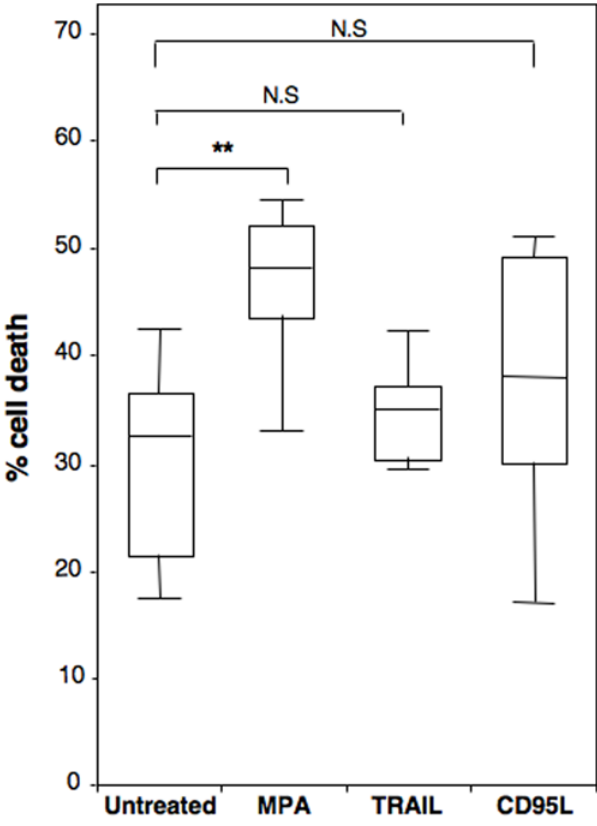
Figure 5. MPA treatment efficiently kills B-CLL cells. Leukemic B- cells isolated from CLL patients (n=14) were treated with either the apoptotic inducers TRAIL (500 ng/ml) or CD95L (500 ng/ml) or with MPA (10 m g/ml) for 72 hours. Then total cell death was quantified using the metabolic assay MTT (total cell death). Statistical analysis was performed using a non-parametric Mann-Whitney two sample ranksum test (n=14). N.S means non-significant and ** P # 0.01.